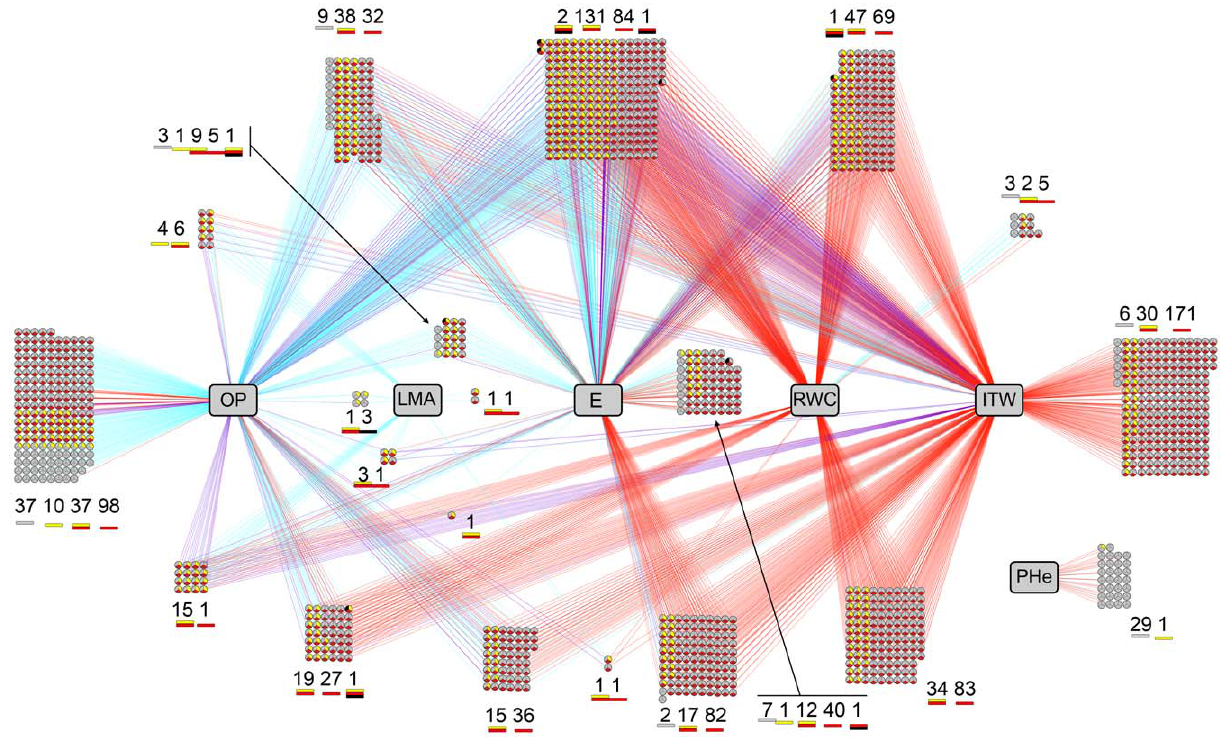
Figure 4. Gene-Phenotype network produced by SPLS, based on responses of eight sunflower genotypes to two drought stress scenarios implemented in controlled environment. Genes presenting absolute correlation scores higher than 0.65 with at least one morpho- physiological variable are represented. Each circle represents one gene. Blue, red and purple edges indicate, respectively, whether the gene- phenotype association exists under FDS, FIS or both stress scenarios. Each gene circle is split in three slices displaying ANOVA results. Yellow, red and black slices represent, respectively, treatment effect under FDS (moderate stress responsive genes), treatment effect under FIS (severe stress responsive genes), and g*t effect under FIS (gene likely to explain genotypic differences in stress responses). Numbers of genes for each combination of ANOVA effects are shown for each gene-phenotype group. Phenotypic responses are in gray squares, OP: Osmotic Potential, LMA: Leaf Mass Area, E: Transpiration Rate, RWC: Relative Water Content, ITW: Integrated Transpired Water, PHe: Plant